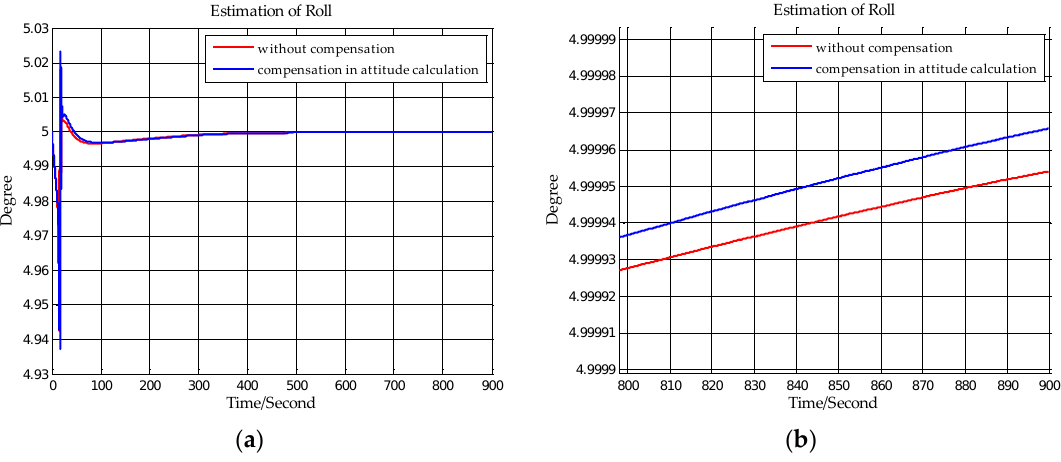
Figure 10. ( a ) is the estimation of roll with compensation in attitude calculation, and ( b ) is the enlarged view of ( a ) in the last 100 s.